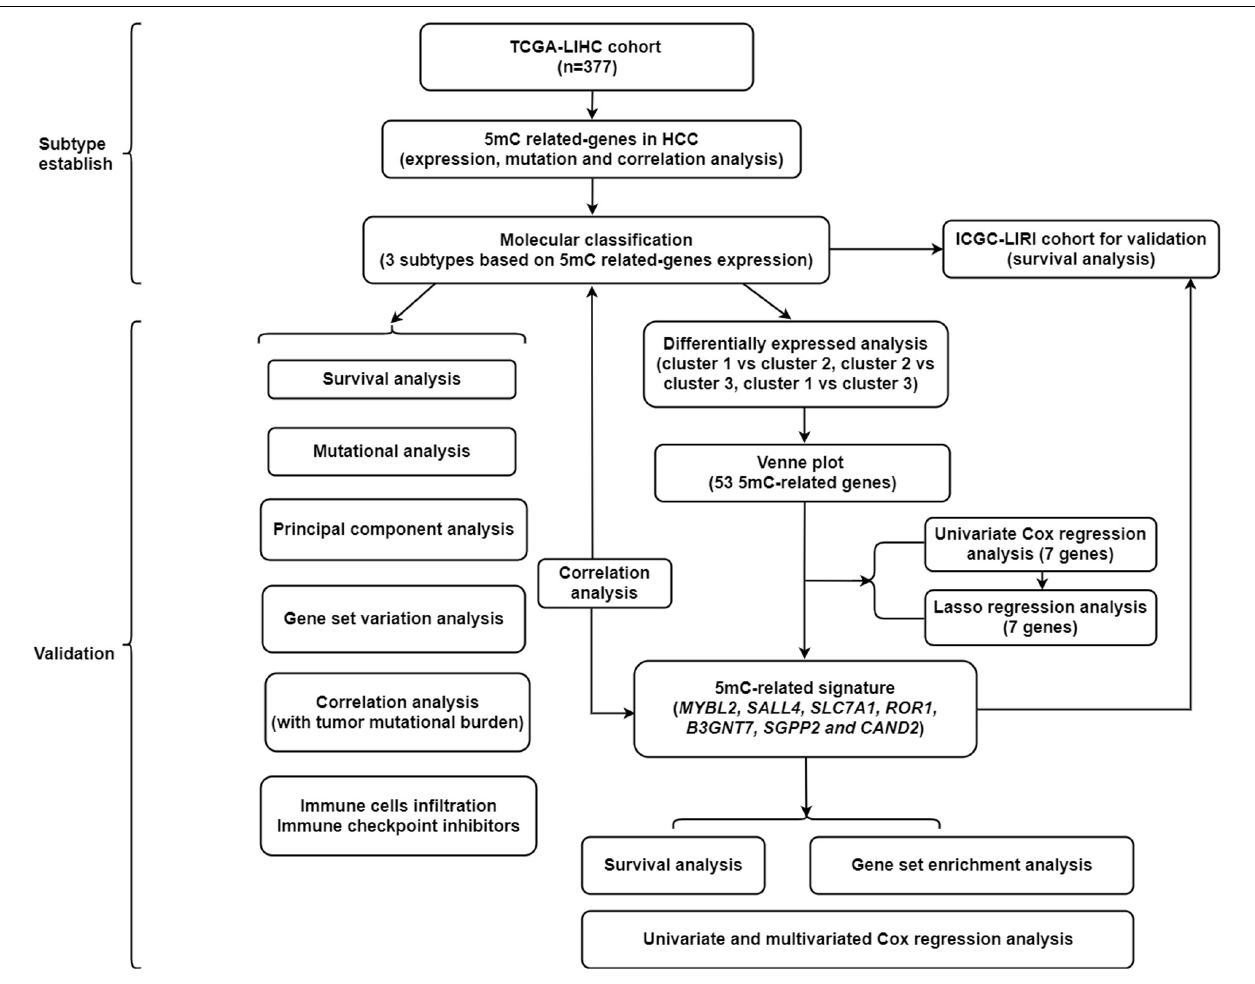
FIGURE 1 | The flowchart of this